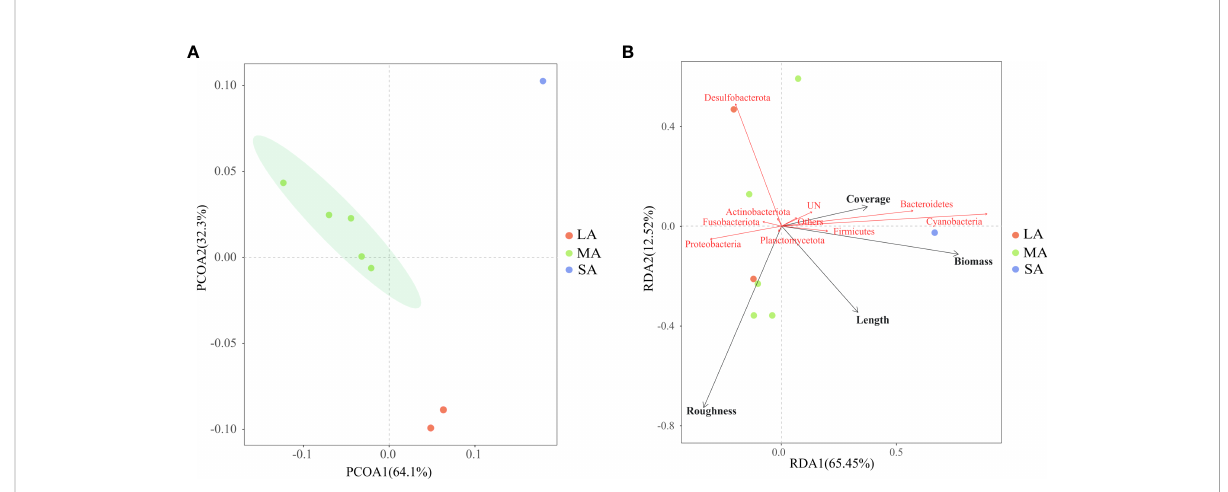
FIGURE 4 Beta diversity analysis of EAM microbiota. (A) UniFrac-PCoA analysis of EAM microbiota based on unweighted UNIFRAC distance; (B) redundancy analysis of EAM microbiota and potential in fl uencing factors based on Hellinger distance matrices (The percentage on the coordinate axis represents the interpretation of the total variation of that axis. The different substrates were divided into three categories: short EAM [SA], medium EAM [MA], and long EAM